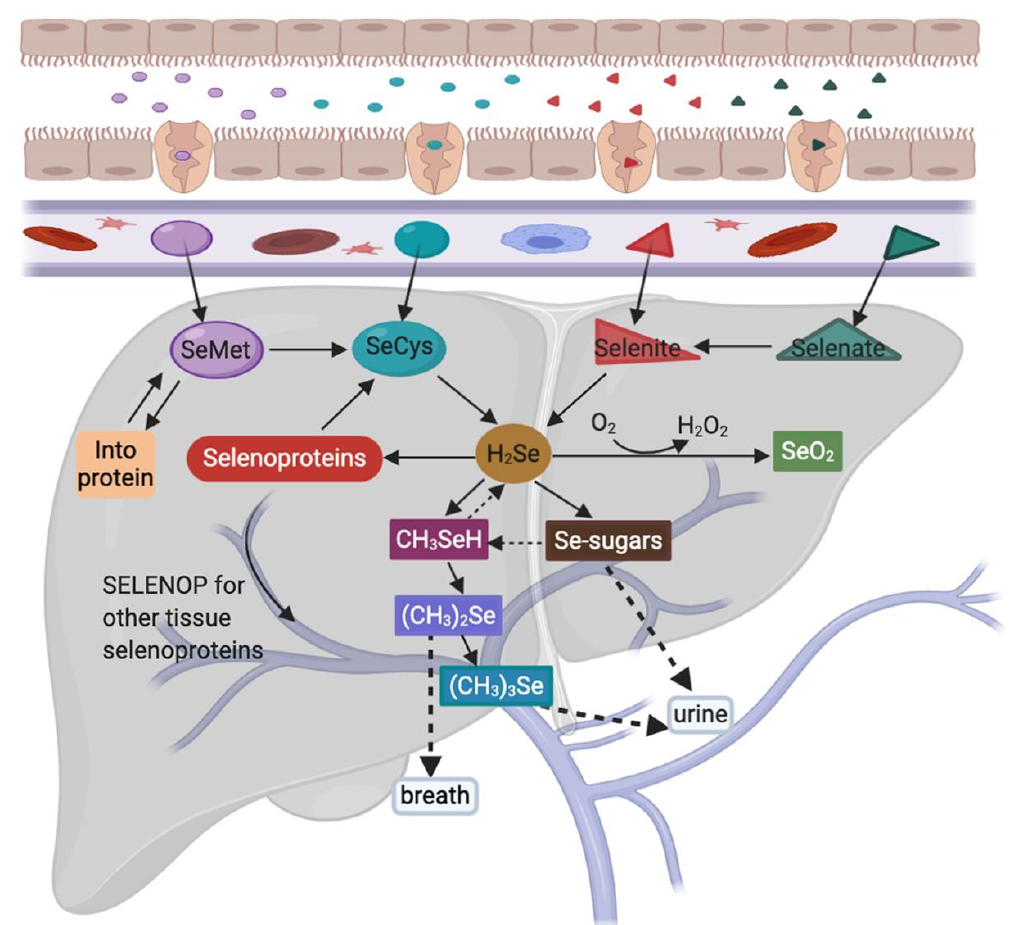
Figure 1. The metabolism of Se dietary forms. SeMet, (selenomethionine); SeCys, (selenocysteine); H 2 Se, (dihydrogen selenide); SELENOP, (selenoprotein P); CH 3 SeH, (methyl selenol); (CH 3 ) 2 Se, (dimethyl selenide); (CH 3 ) 3 Se + , (trimethyl selenonium); SeO 2 , (selenium dioxide).